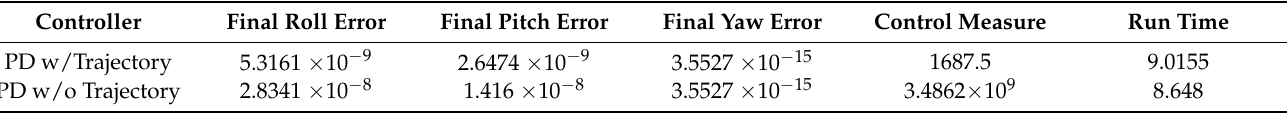
Table 7. Comparison of PD control with and without Pontryagin Optimal Trajectory in non-principal frame with elevated gains of K P = 1,000,000 and K D =